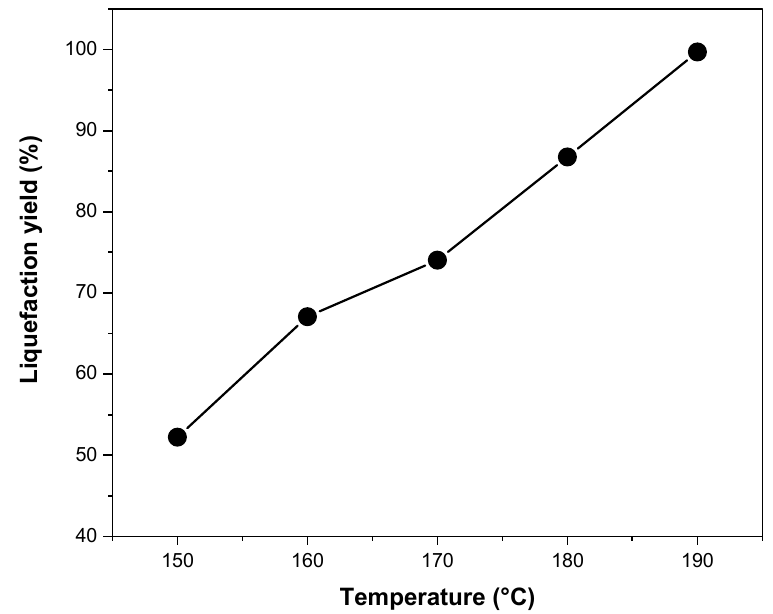
Figure 1. Effect of temperature on the liquefaction yield. Liquefaction time, 90 min; sulfuric acid, 3%; liquefying solvent, EG; solvent to biomass ratio, 3:1.